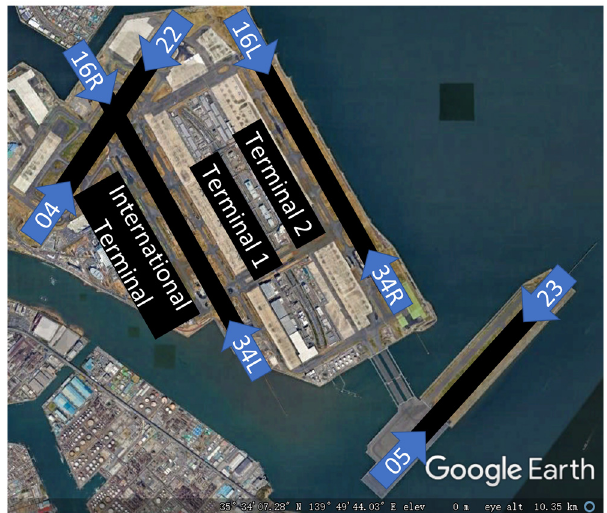
Figure 1. Location of runways and terminals at the Tokyo International Airport. Source: Google Earth (2020) [17].